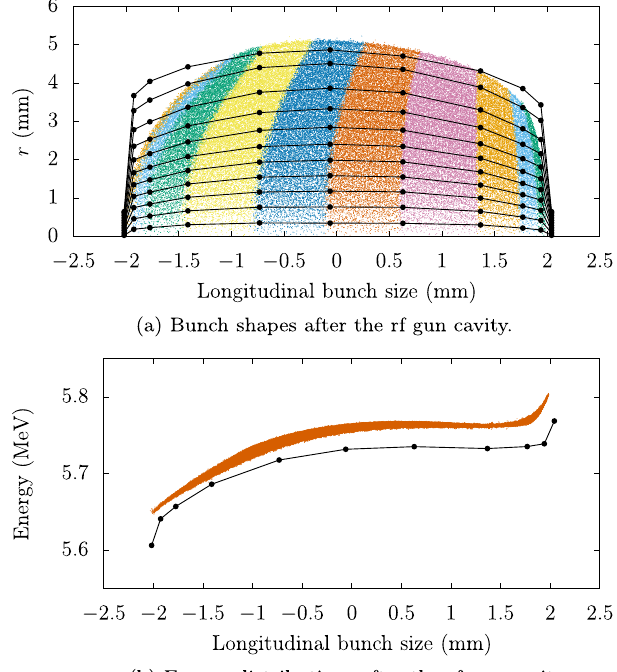
FIG. 6. Beam dynamics calculated using the multiple beam envelope equations for a charge of 1.0 nC per bunch in the BNL-type rf gun